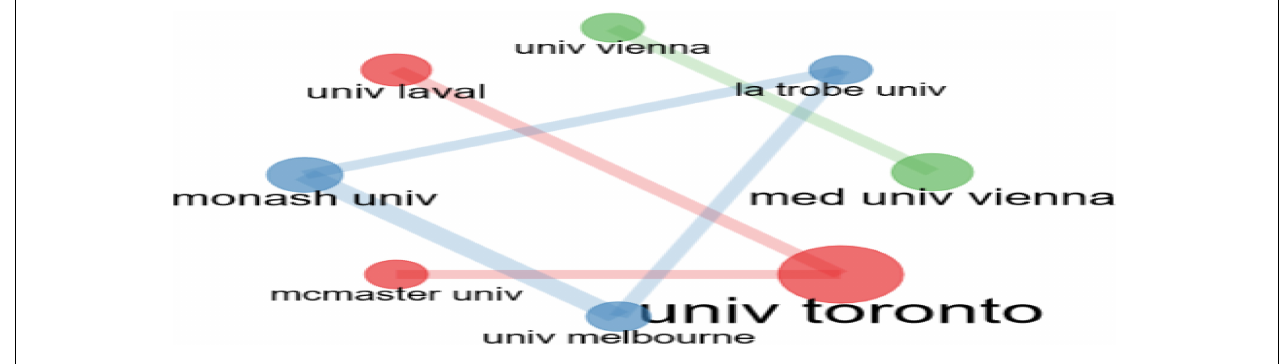
FIGURE 7 | Collaboration among research institutions.